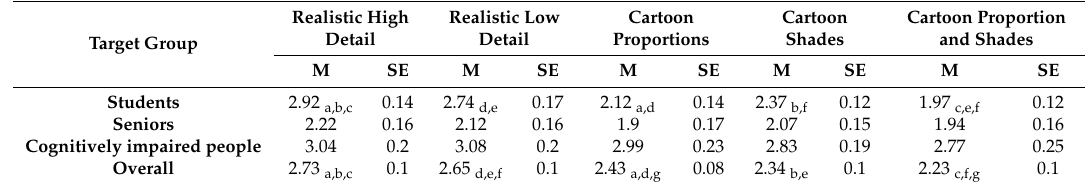
Table 4. Liking of the agent for degrees of realism from all target groups.